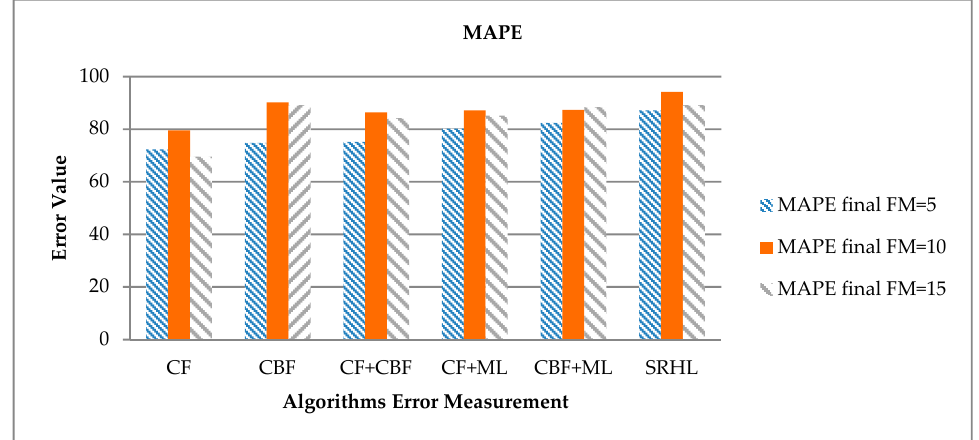
Figure 9. Each experiment’s MAPE results .